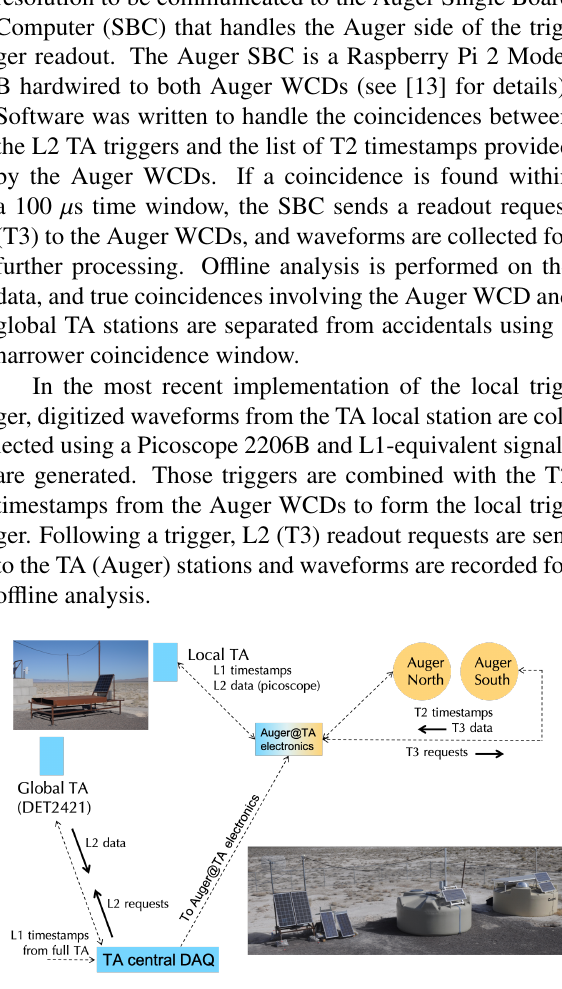
Figure 2. Data acquisition flow of the Auger and TA stations (see text for